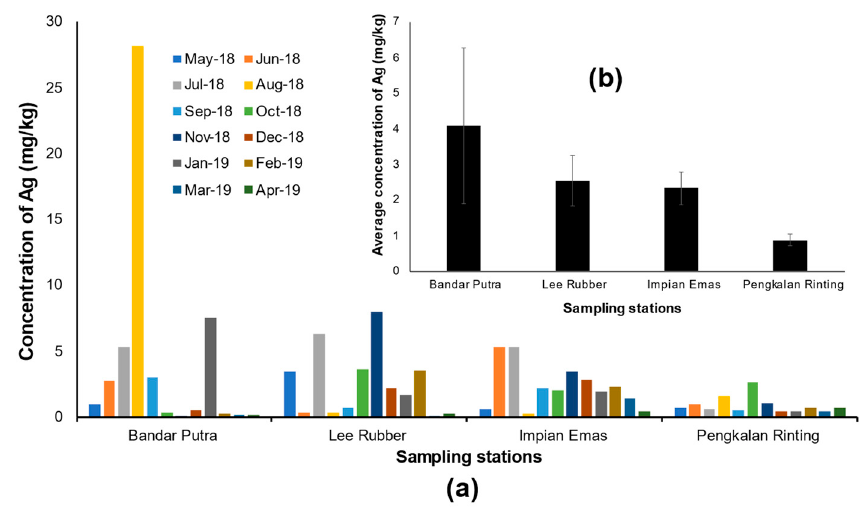
Figure 5. ( a ) Monthly Ag concentrations in sediment samples over the one-year sampling period and ( b ) average Ag concentrations by sampling station.